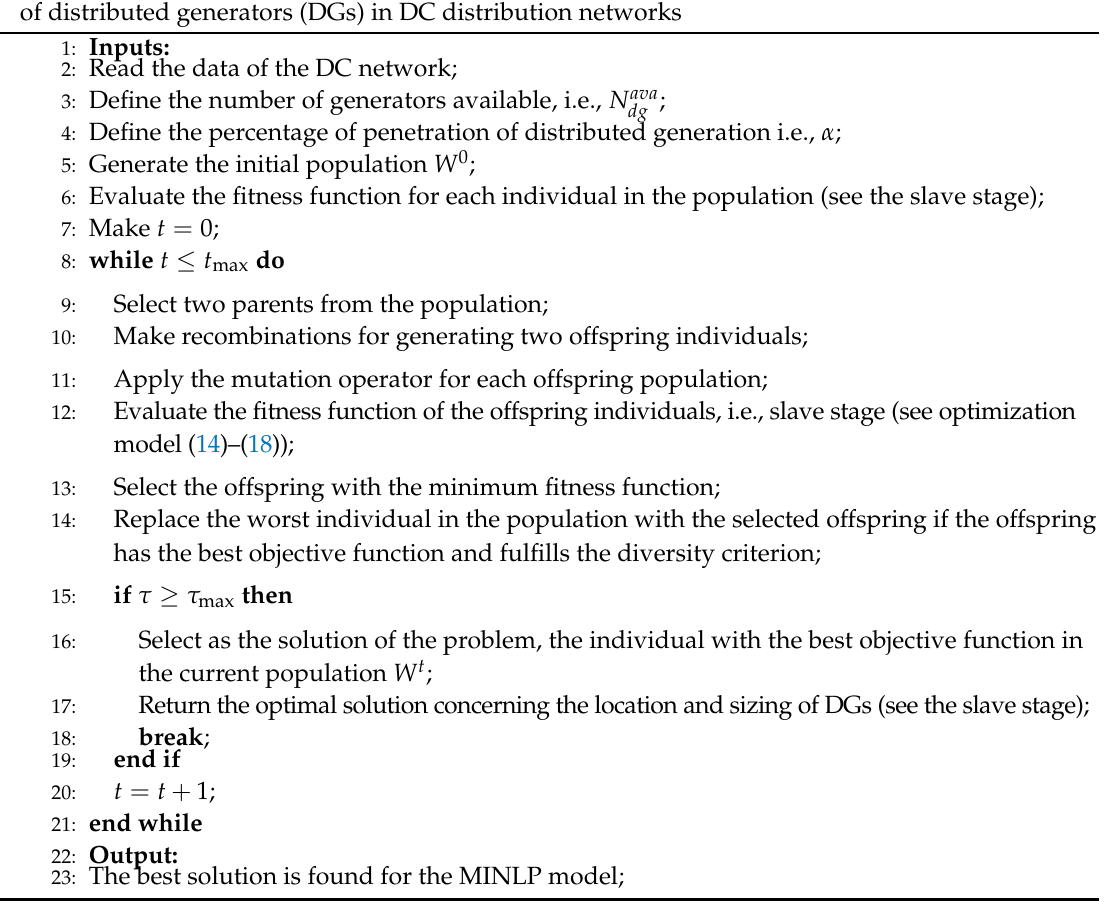
Algorithm 1: Proposed master-slave optimization approach for the optimal location and sizing of distributed generators (DGs) in DC distribution